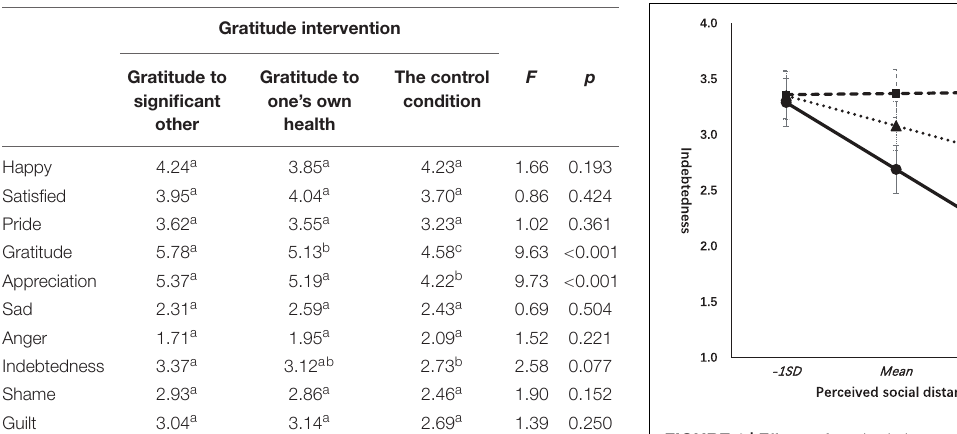
FIGURE 1 | Effects of gratitude interventions on indebtedness across levels of perceived social